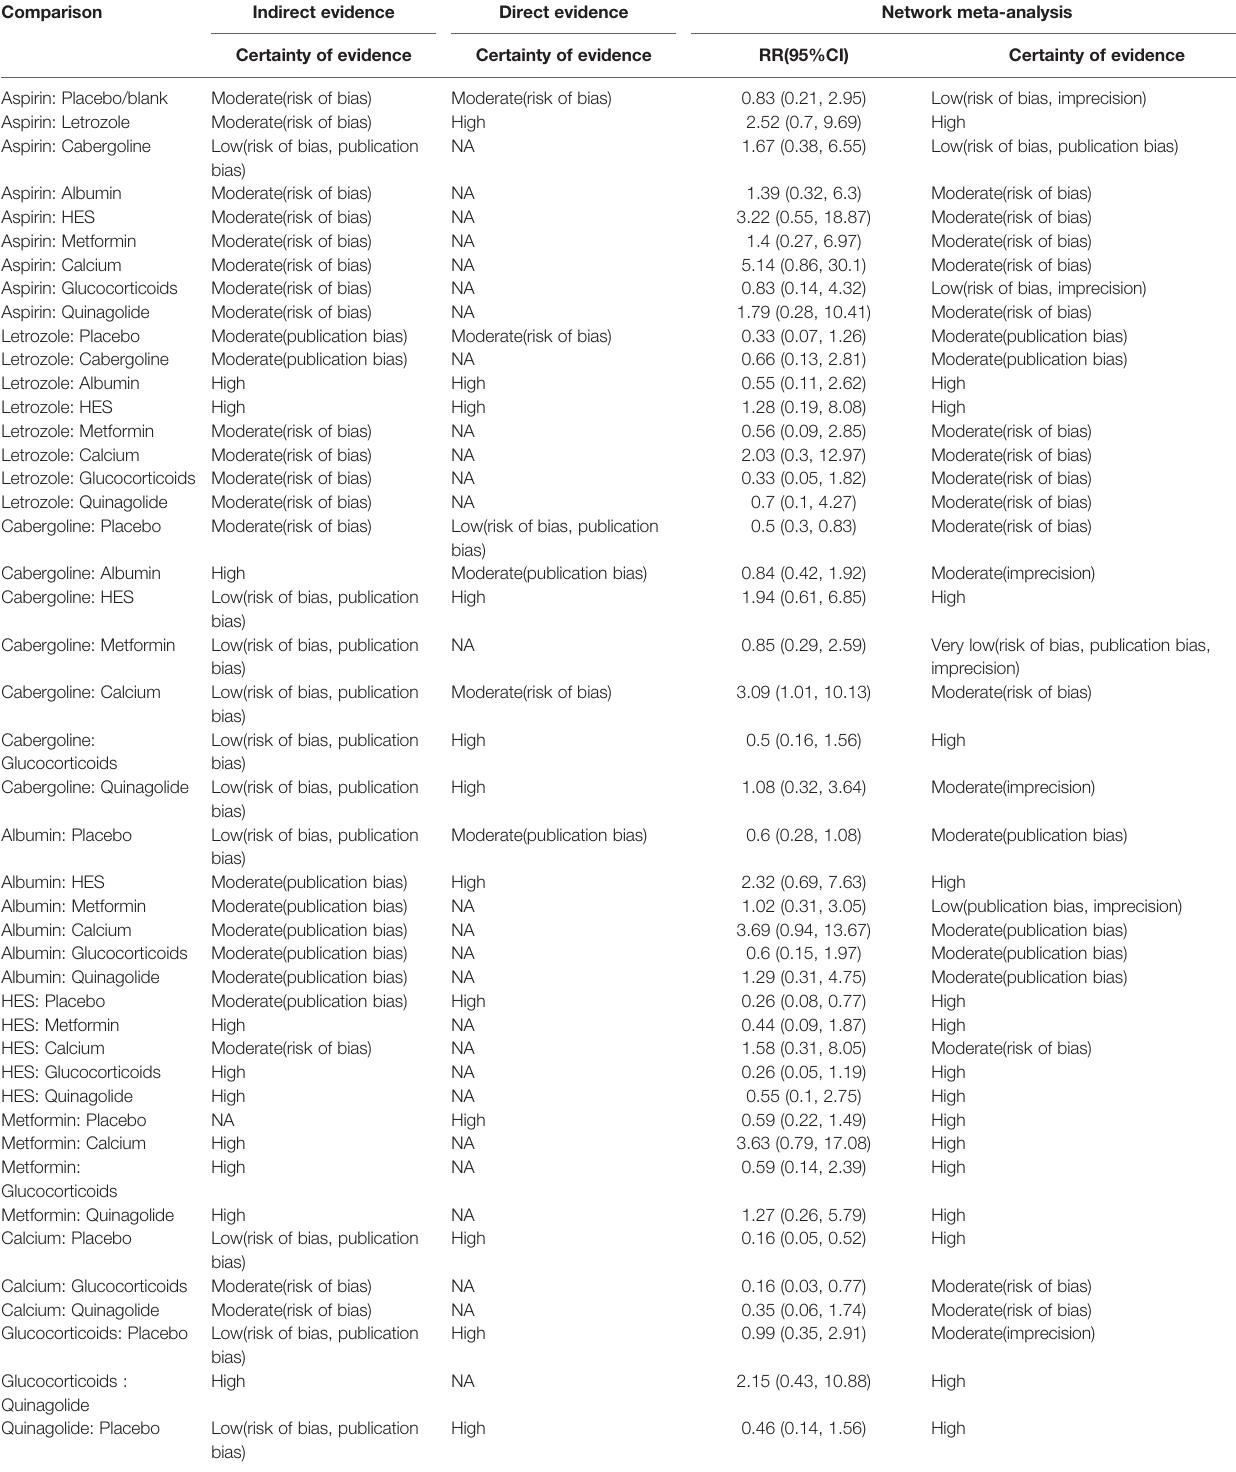
TABLE 1 | Quality of evidence for moderate-to-severe OHSS.